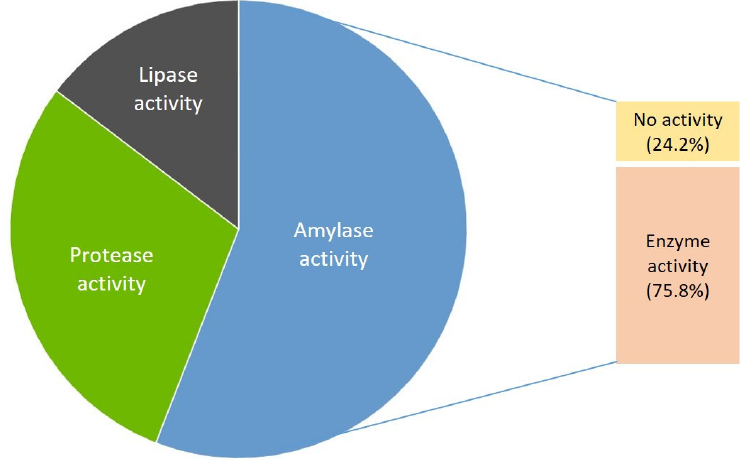
Figure 3. Production of extracellular hydrolase among isolates. Table 5. Amount of extracellular hydrolases produced by thermophilic isolates expressed as EI.